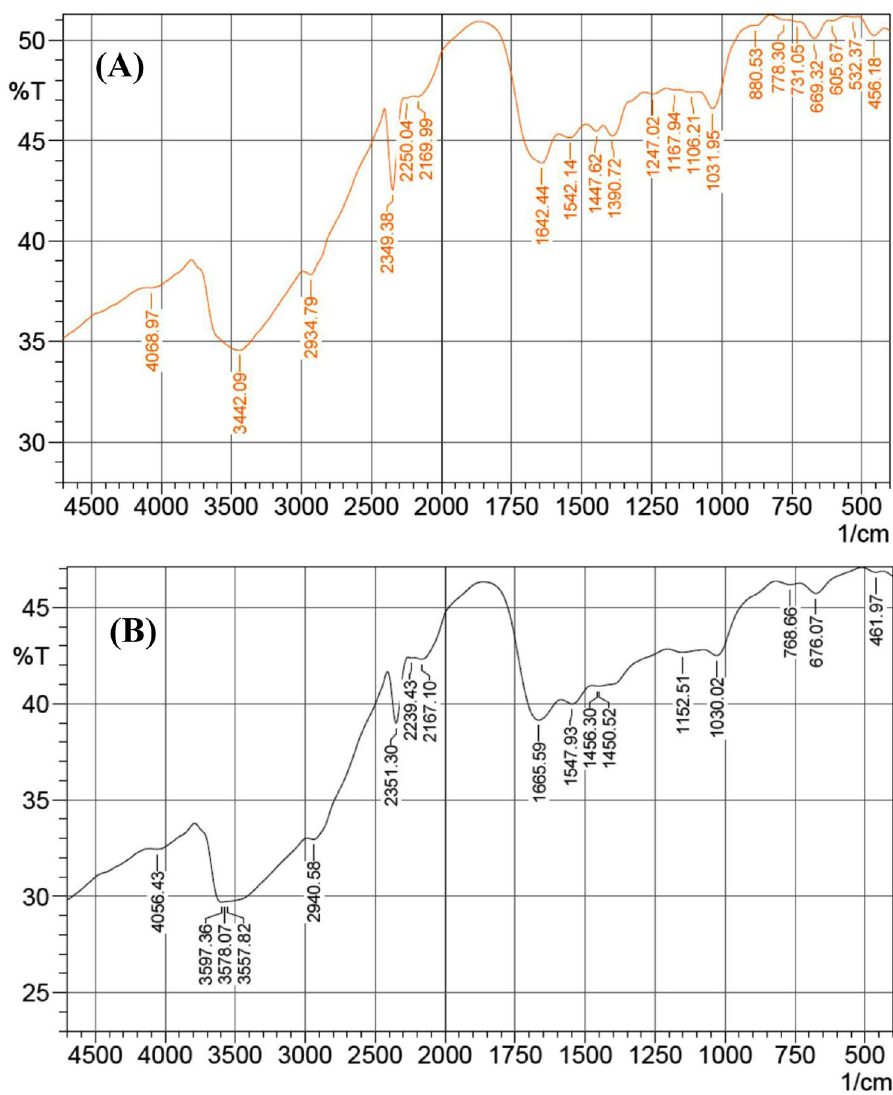
Figure 8. FTIR analysis of Gelidium corneum biomass: ( A ) before and ( B ) after simultaneous biosorption of Hg 2+ and Remazol brilliant blue